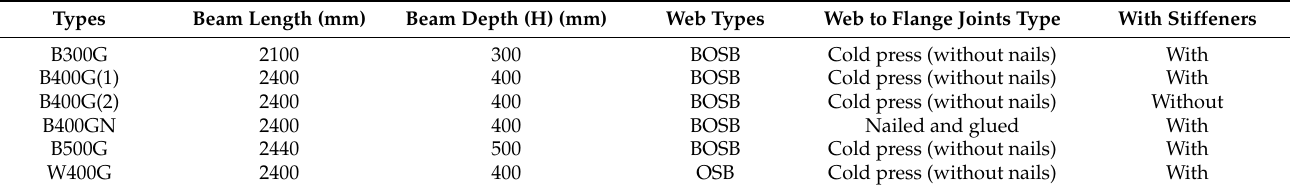
Table 2. Experimental design of